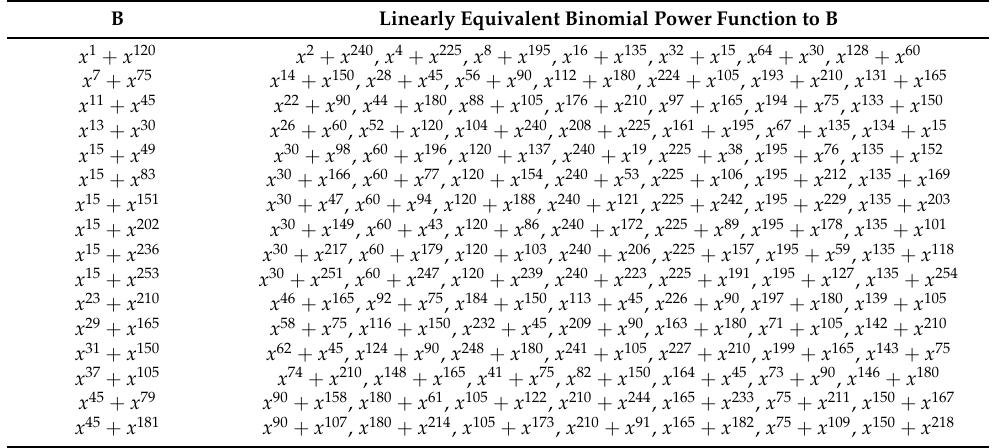
Table A2. Classification of Linearly Non-Equivalent Binomial Power Function with 17 to 1 Output.